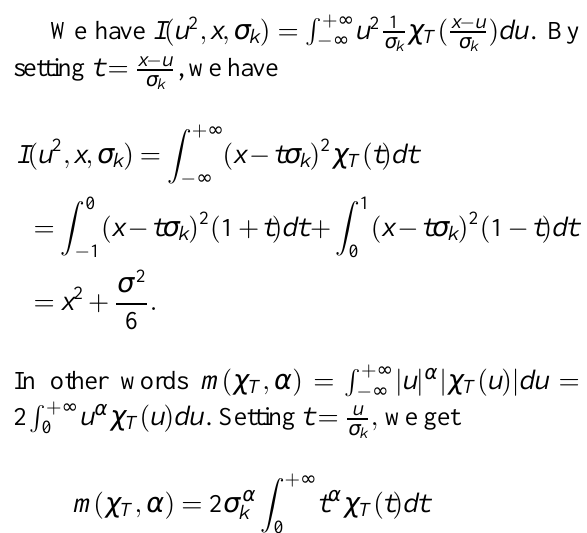
Fig. 1. Triangular set function.